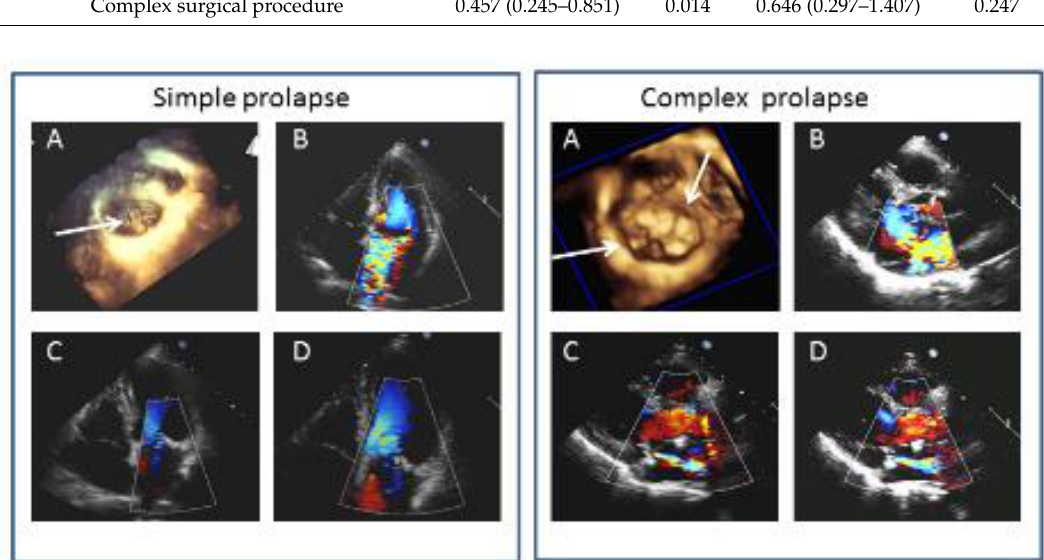
Figure 2. Left panels: Example of simple mitral valve prolapse (MVP). ( A ) surgical view of three-dimensional MVP reconstruction showing P2 prolapse with multiple chordal ruptures (arrow). ( B ) two-dimensional transthoracic 4 chamber apical view showing a severe mitral regurgitation (MR). ( C , D ) two-dimensional transthoracic 4 chamber apical views at 6M and 3Y follow-up, respectively, with trivial MR. Right panels: example of complex MVP. ( A ) surgical view of three-dimensional MVP reconstruction showing A2, A3, P2 prolapse (arrows) ( B ) two-dimensional transthoracic parasternal view showing severe MR central jet. ( C , D ) two-dimensional parasternal long axis views at 6M and 3Y follow-up, respectively, with mild to moderate MR.